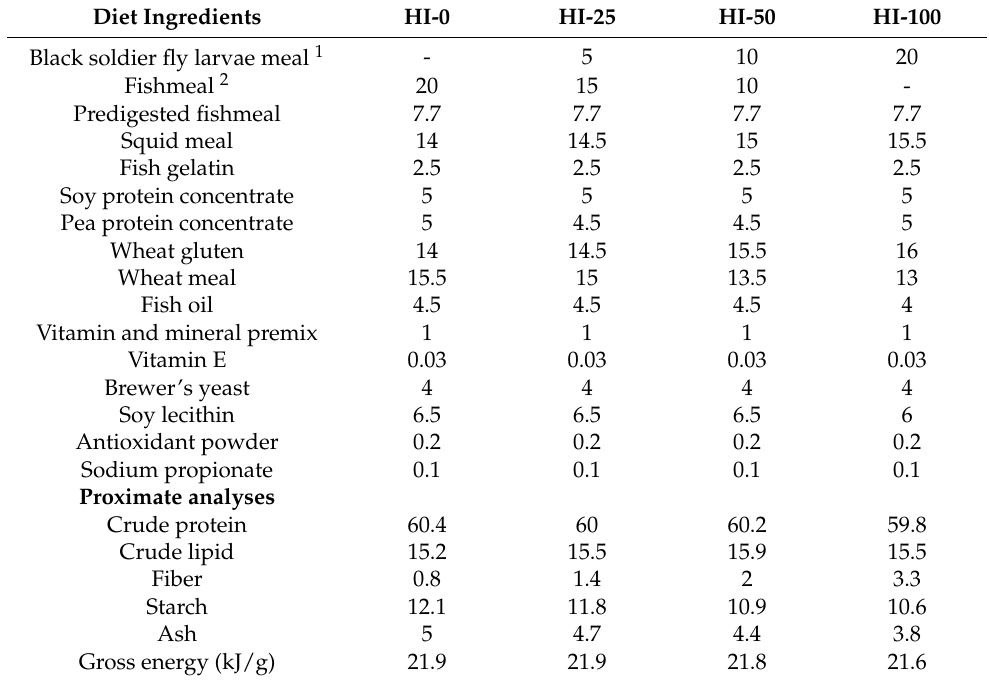
Table 1. Ingredient composition and proximate analysis of experimental diets (% on a dry-matter basis).